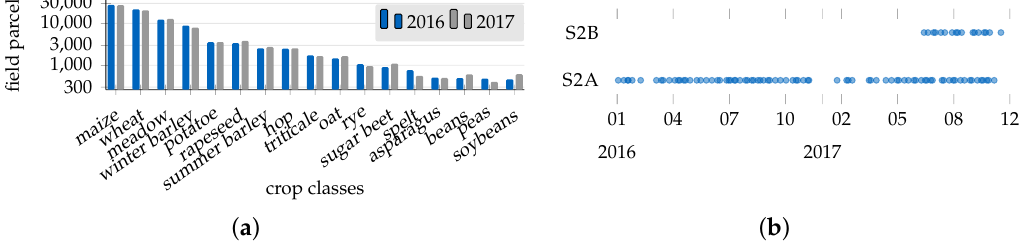
Figure 5. Information of the area of interest containing location, division schemes, class distributions and dates of acquired satellite imagery. ( a ) Non-uniform distribution of field classes in the AOI; ( b ) acquired Sentinel 2 (S2) observations of the twin satellites S2A and